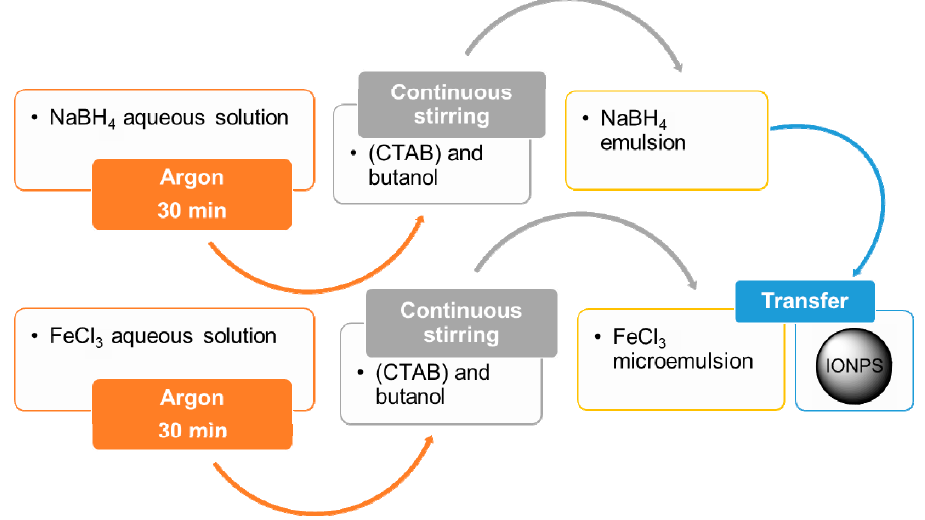
Figure 3. Flowchart for the synthesis of IONPs by microemulsion. Two W/O microemulsions (respectively with FeCl 3 and NaBH 4 in aqueous solution) are used for the preparation of MNPs with an iron core coated by a Fe 3 O 4 shell [28]. Abbreviation: CTAB = cetyltrimethylammonium bromide.